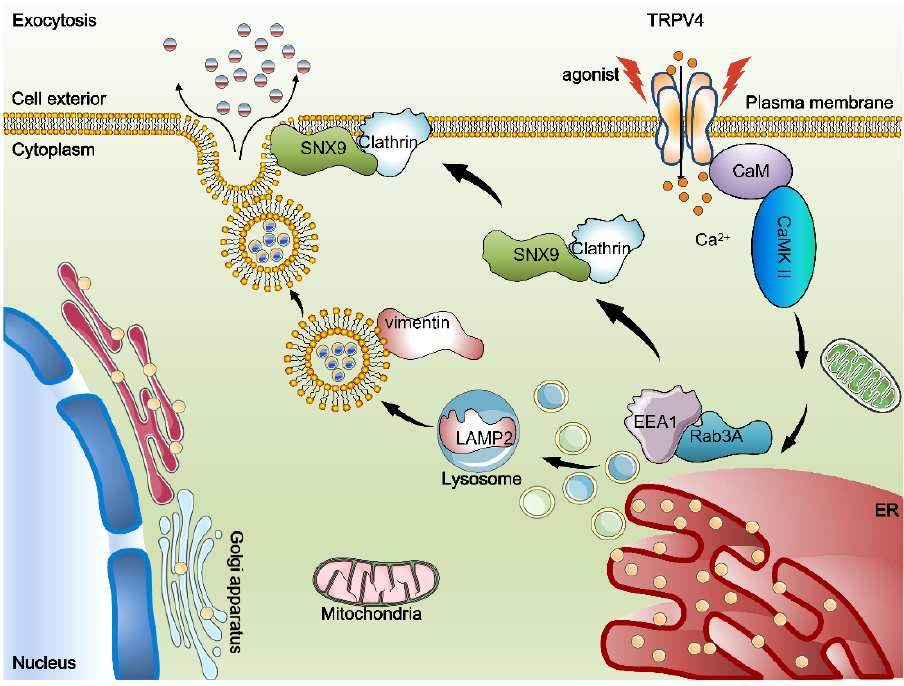
Figure 8 . Proposed model of exocytosis by activation of TRPV4 upon agonist